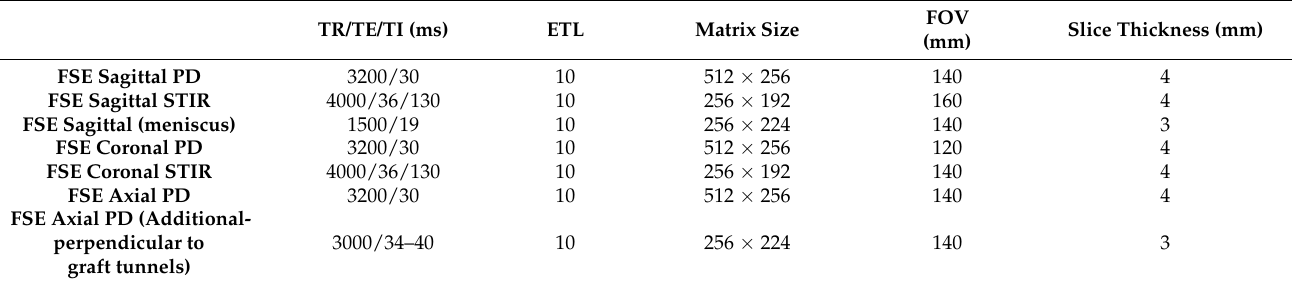
Table 2. Summary of MRI scanning parameters by image type. Parameters shown are repetition time (TR), echo time (TE), inversion time (TI), echo train length (ETL), matrix size, field of view (FOV), and slice thickness (with 0 mm